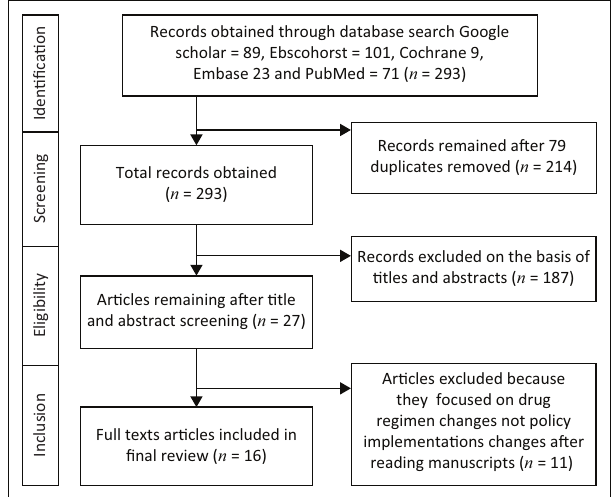
FIGURE 1: Preferred reporting items for systematic reviews and meta-analysis flow diagram showing the process of selecting articles included in the